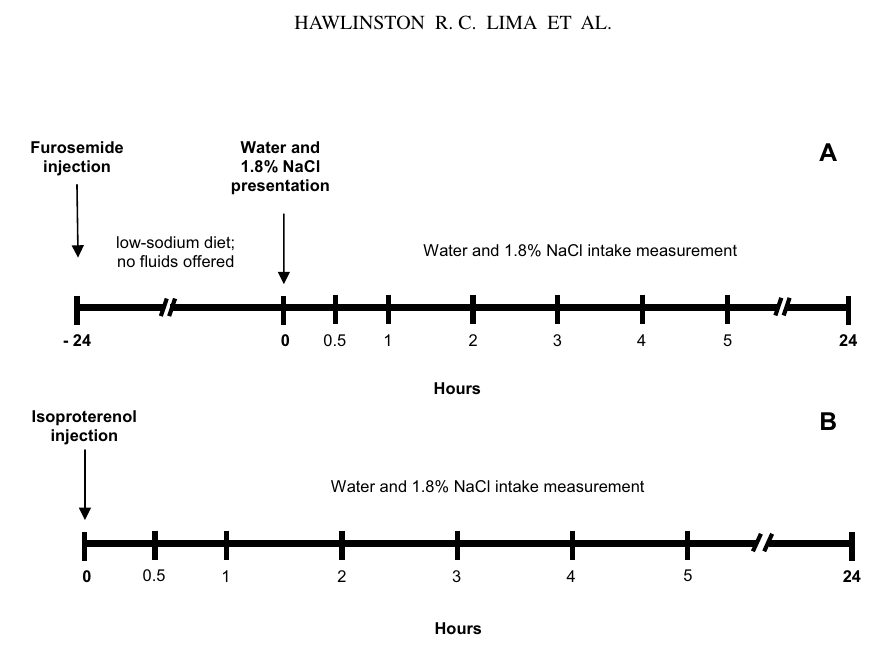
Fig. 1 – Schematic representation of the experimental protocols used in the evaluation of 1.8% NaCl and water intake in rats treated with p-chlorophenylalanine (PCPA) and depleted of sodium by furosemide (A) or injected with isoproterenol (B).